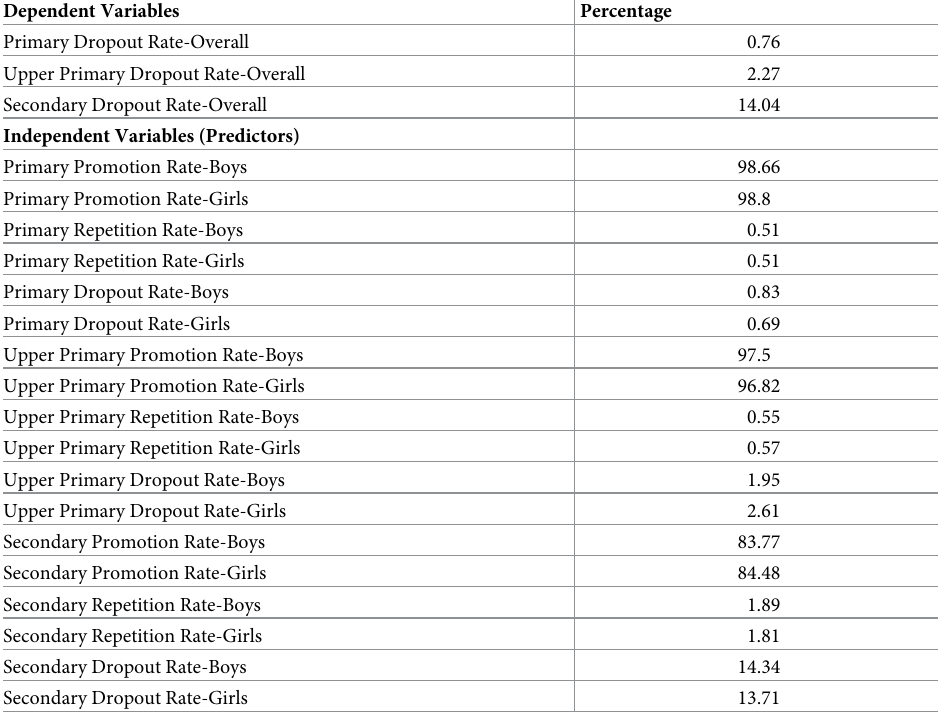
Table 1. Rates of promotion rate, repetition rate, and dropout rate in India-2019-2020. Dependent Variables